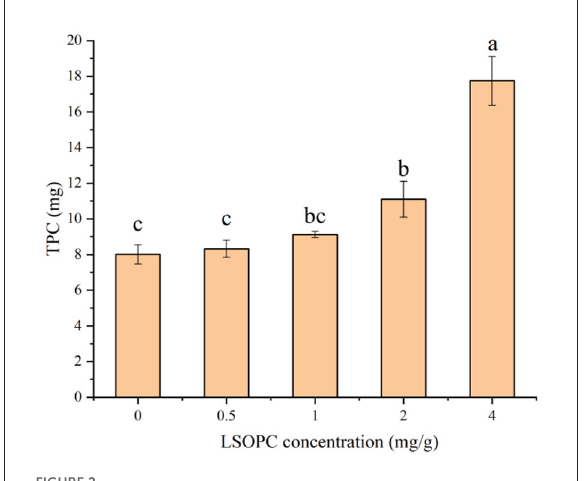
FIGURE2 Effect of different concentrations of LSOPC on total phenol content in biscuits. Significant differences ( p < 0.05) of data values were indicated by different letters.